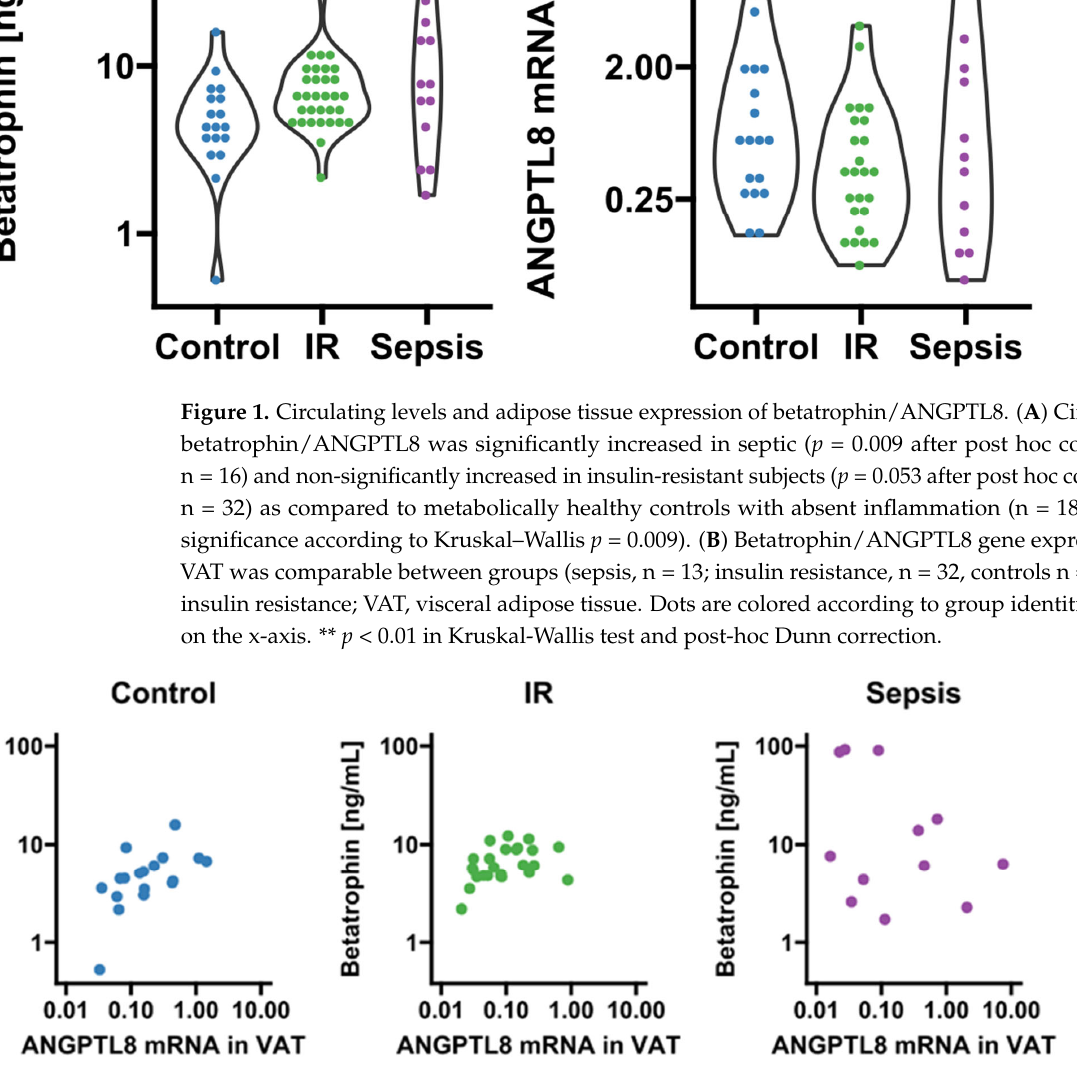
Figure 2. Correlation analysis of betatrophin/ANGPTL8 circulating levels and VAT mRNA expres- sion. Correlations were observed in subjects free from inflammation and metabolic dysregulation (r = 0.61; p = 0.008) and in insulin-resistant patients (r = 0.43; p = 0.034), but not in the sepsis group (r = − 0.32; p = 0.34). IR, insulin resistance; VAT, visceral adipose tissue. Dots are colored according to group identities given in panel titles.